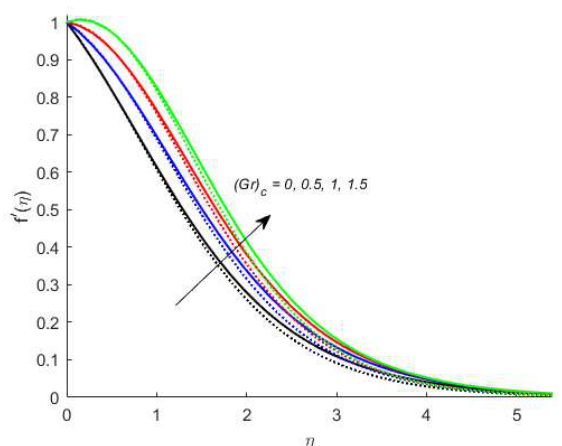
Figure 3. Velocity profile for ( Gr ) when Ha 2 = 0.2, Pr = 2.36, Ec = 0.01, Sc = 0.8, Sr = 0.1, K = 0.1, Bi = 0.05, and β ∗ = 0.1.